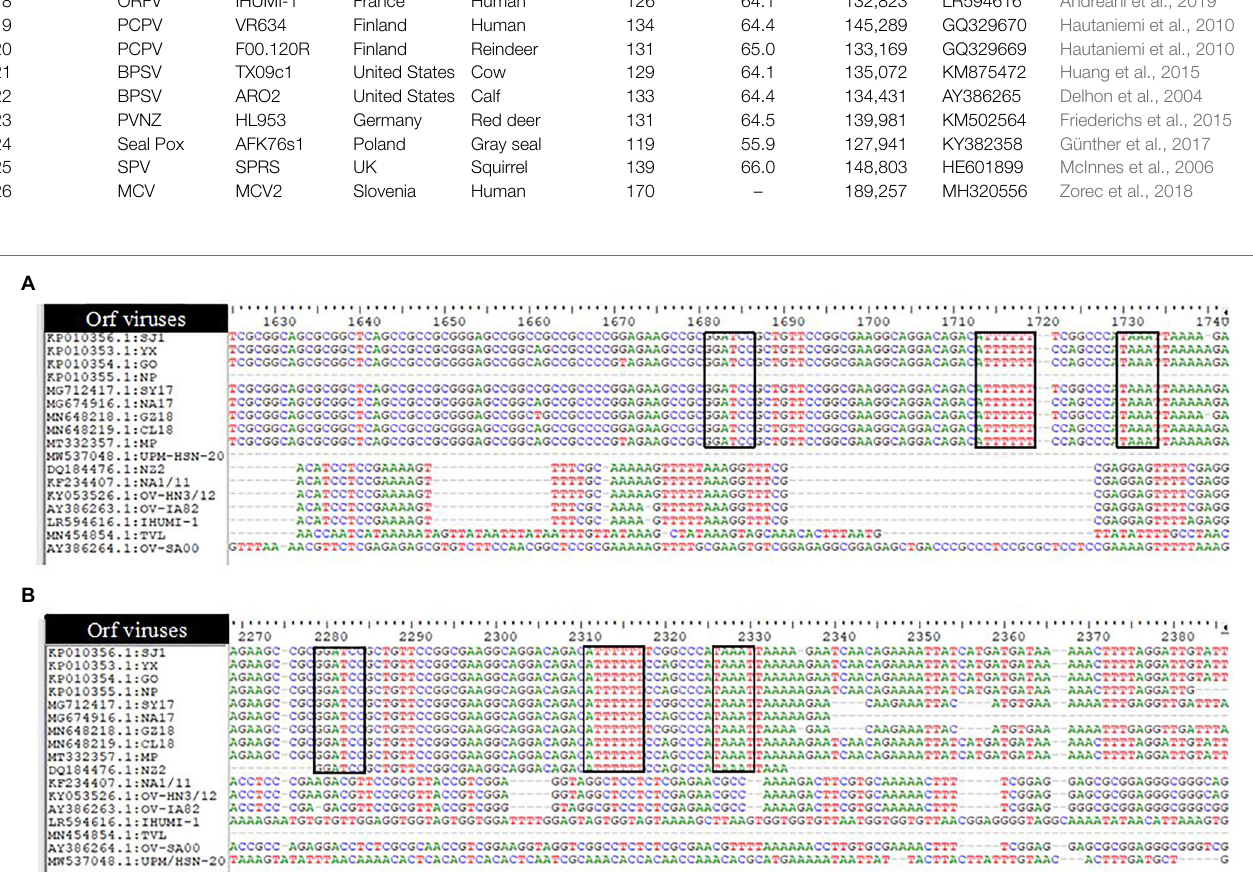
FIGURE 2 | Analysis of ITRs of 17 Orfvimses (A) the left end (5') sequence alignment (B) the right end (3') sequence alignment. The tenninal BamHI site, telomere resolution motif are indicated with black box